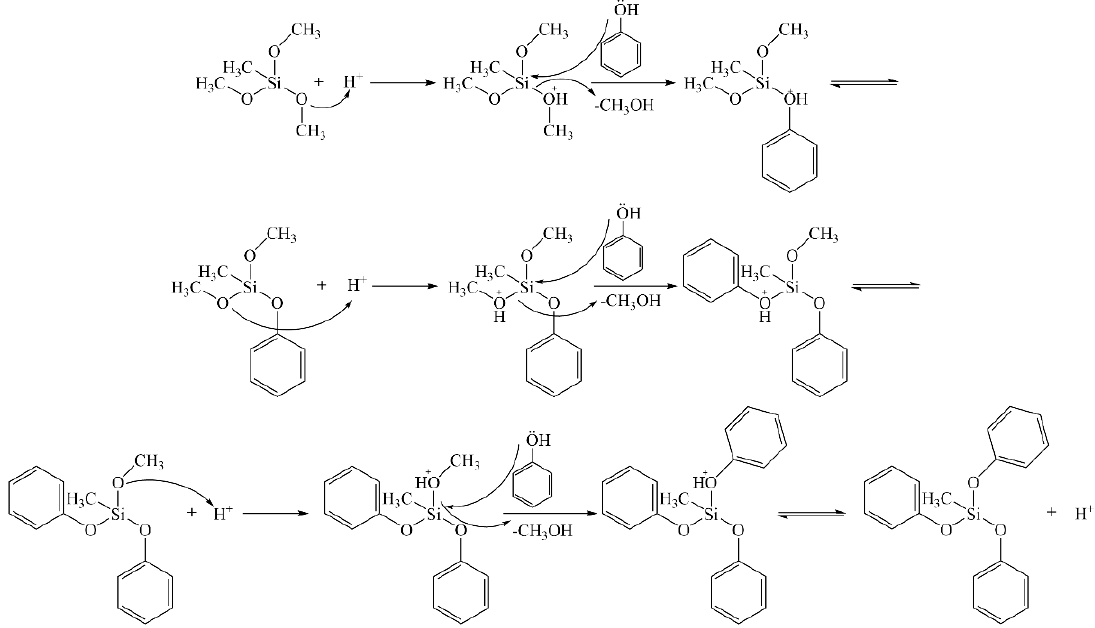
Figure 1. Preparation of methyl-trimethoxy-silane intermediates by transesterification. Secondly, paraformaldehyde (POM) is added to the reaction system to further react with the generated methyl-trimethoxy-silane intermediates. In an acidic environment, POM will depolymerize and first react with the ortho- and para-positions of the benzene ring in methyl-trimethoxy-silane intermediates to produce two transition state intermediates. These two intermediates then continue to react with methyl-trimethoxy-silane to form three oligomers with the formulas 2,2’, 2,4’, and 4,4’. As the degree of